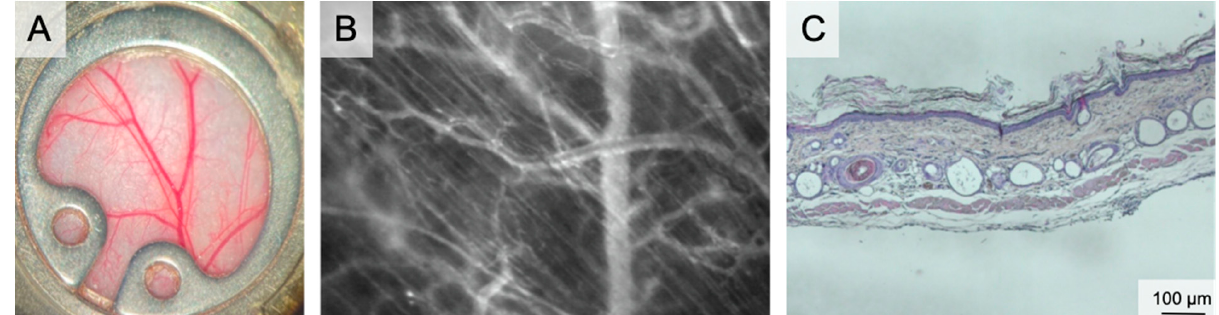
Figure 1. The dorsal skinfold chamber. ( A ) macroscopic image of the dorsal skinfold chamber following preparation of the subcutaneous vasculature. The chamber is filled with saline and closed by a coverslip. ( B ) Intravital microscopy showing the microvascular network including capillaries, venules and arterioles in 100 × magnification following iv FITC-dextran injection. ( C ) Overview of the dorsal skinfold chamber anatomy in HE staining.